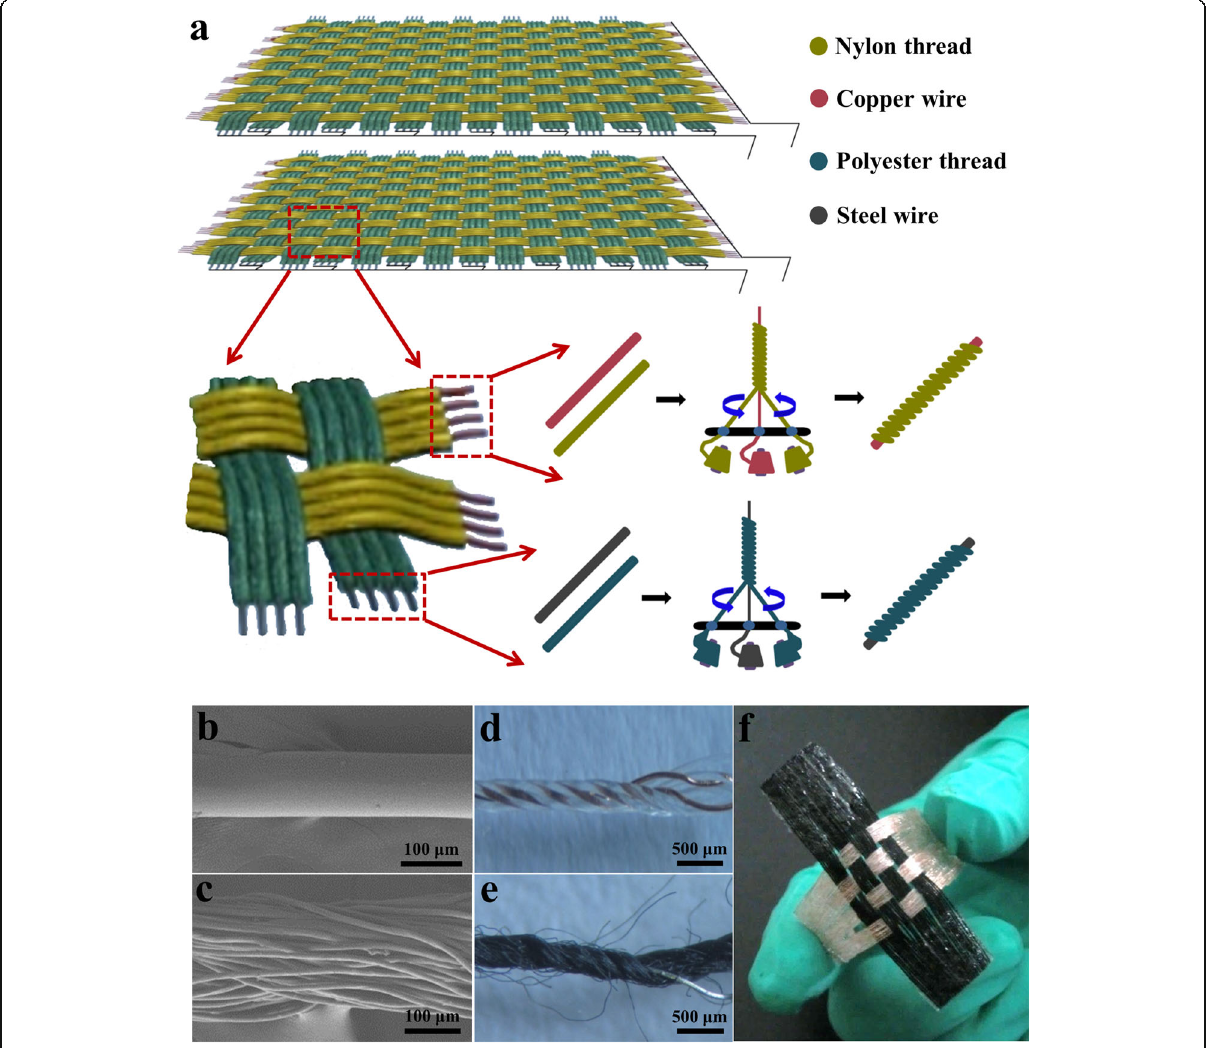
Fig. 1 Fabrication and structure of the 2DW-WTNG. a Schematic diagram illustrating the fabrication process. SEM images of the nylon thread ( b ) and the polyester thread ( c ), respectively. Optical images of the nylon thread coated copper wire ( d ) and the polyester thread coated steel wire ( e ), respectively. f Optical images of the